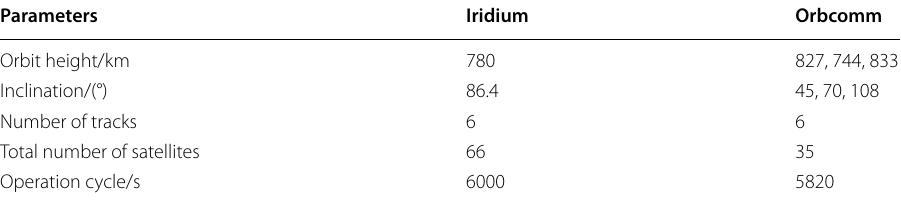
Table 1 Iridium and Orbcomm simulation